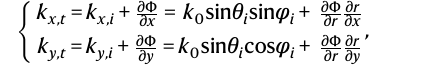
2D and 3D imaging of the scene. b Detail of the cascaded AOD-metasurface assembled de fl ection system. c Top view photography of the optical setup. d Bottom: Graphical representation of the metasurface phase distribution along the radial axis. Top: Representations of beam de fl ection according to the incident beampositioningonthemetasurface.Insetequationrepresentsthephasefunction designed. e Illustrationof axialsymmetryforthelaserimpactpoint. f Photography of the 1cm MS fabricated using nanoimprinting lithography. g SEM image of the sample showing the nanopillar building blocks of varying sizes employed to achievebeamde fl